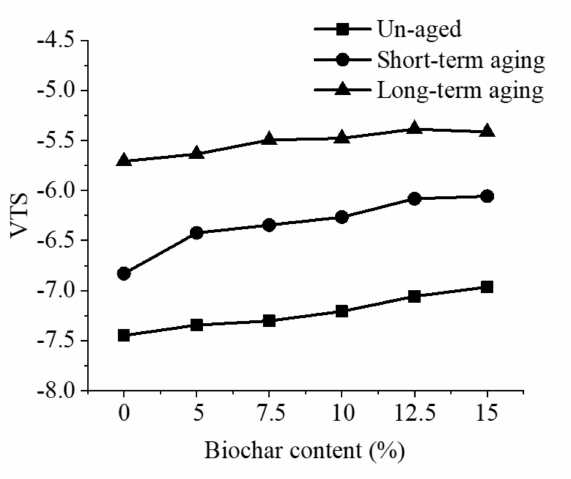
Figure 5. Viscosity–temperature susceptibility (VTS) of biochar modified asphalt binder before and after